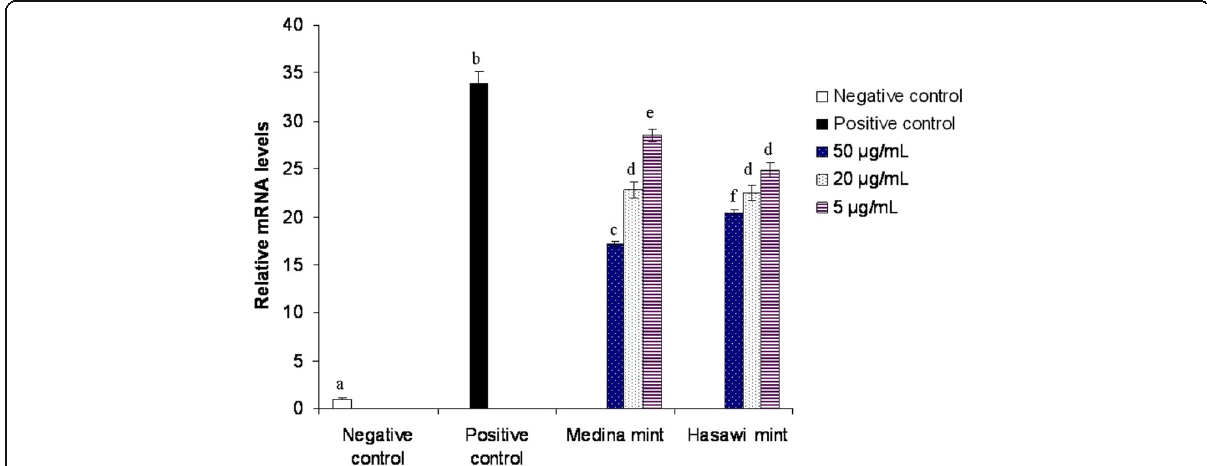
Fig. 3 Inhibitory effect of mint extracts on LPS stimulated COX-2 expression in J774A.1 mouse macrophage cells. Cells were pretreated with samples for 48 h prior to LPS induction, after 4 h of induction, RNA was isolated and COX-2 expression was examined. Negative control indicate COX-2 expression level without LPS stimulation and positive control was measured after 10 ng/mL LPS stimulation for 4